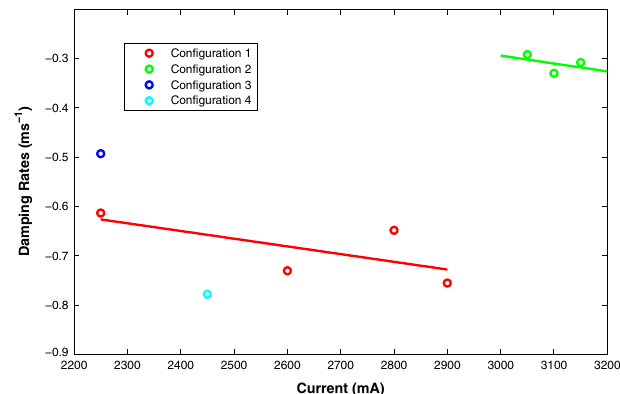
FIG. 5. (Color) LER HOM-driven coupled-bunch modal damp- ing rates (growth plus feedback damping) (from [11]).